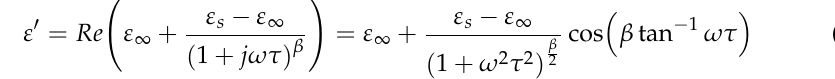
Table 3. Cole-Davidson parameters for nanoribbons and, nanorods. Morphology